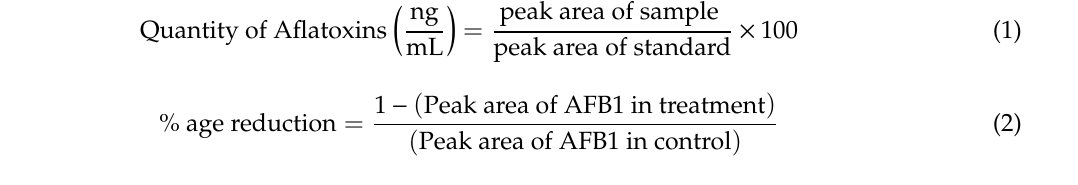
Table 1. Antifungal activity of cell free supernatants of lactobacilli. Isolates GenBank Accession #